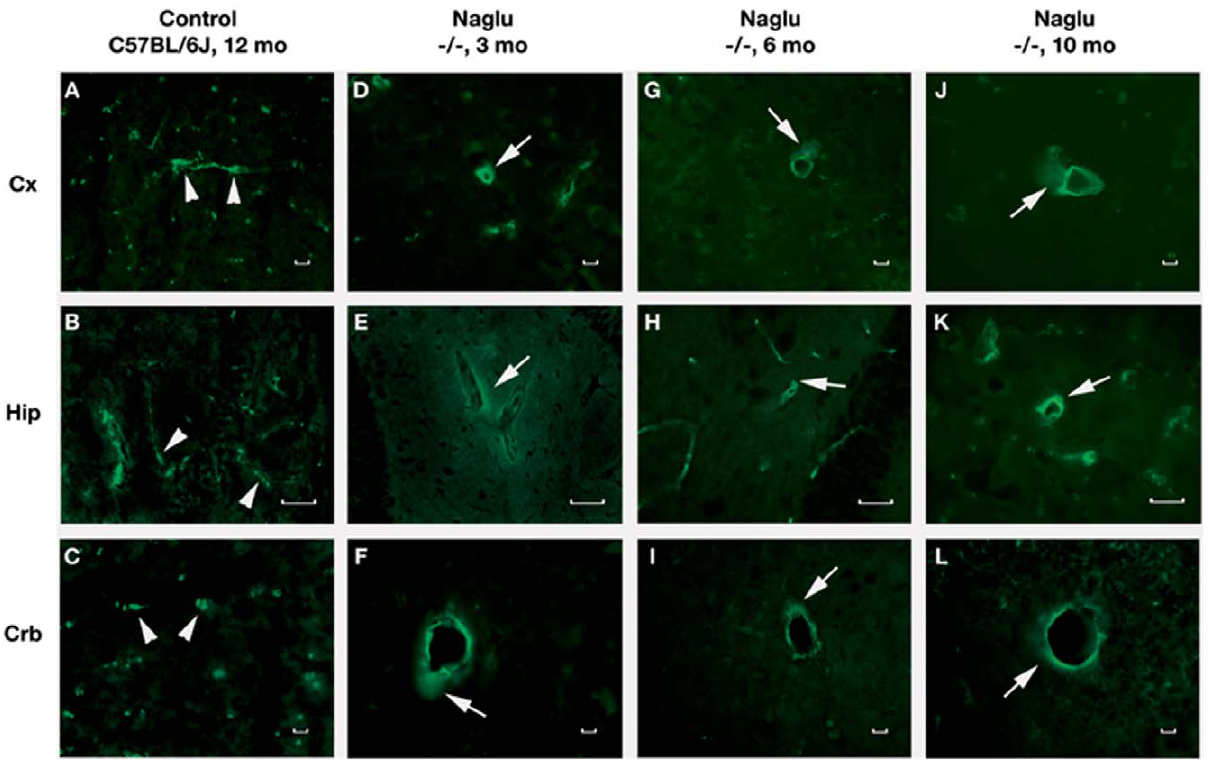
Figure 6. Immunohistochemical staining of albumin in the brains of Naglu mice. Albumin immunostaining can clearly be seen within the blood vessels ( A , B , C , green, arrowheads) of control C57 BL/6J mouse at 12 months of age. In Naglu mice, albumin extravasation (green, arrows) can be seen in various brain structures ( D , E , F ) at early (3 months of age), ( G , H , I ) at late (6 months of age), and ( J, K, L ) end stages of disease (10 months of age). Cx – cerebral cortex, Hip – hippocampus, Crb – cerebellum. Scale bar in A through L is 25 m